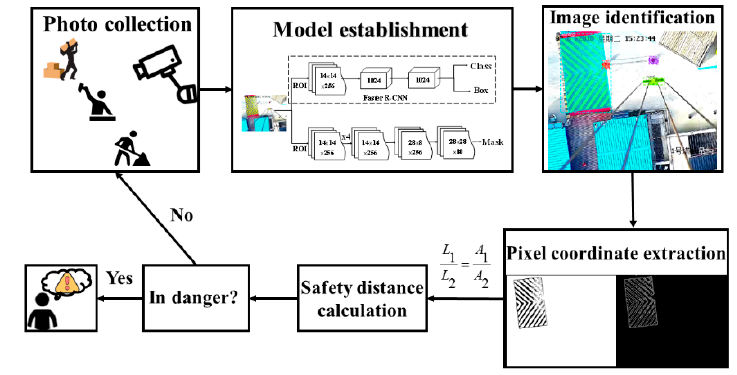
Figure 3. Overall framework of the proposed method.